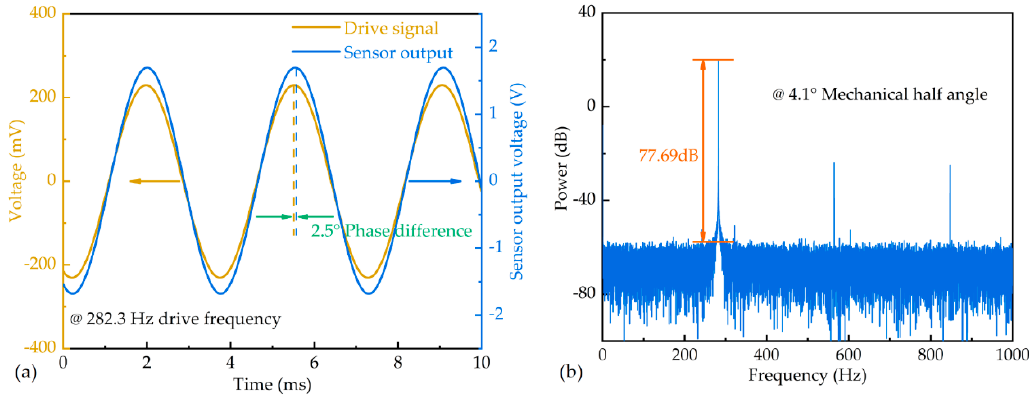
Figure 8. Test results of the acquisition module for the angle sensor output signal. ( a ) Relationship between the driving signal and the sensor signal amplified 500 times in the time domain when the drive frequency is 282.3 Hz and the mechanical half angle of the scanning micrograting is 4.1°; ( b ) frequency spectrum of the sensor signal after going through the module.